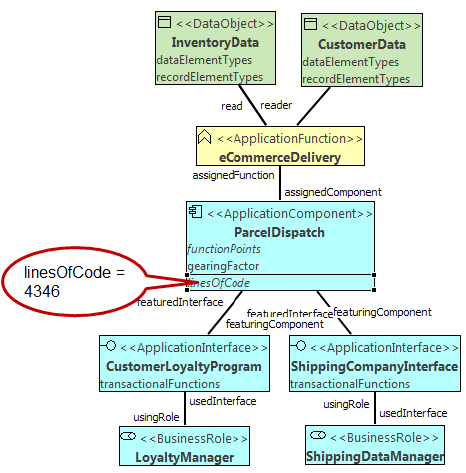
Figure 8. A simple MAPL size model